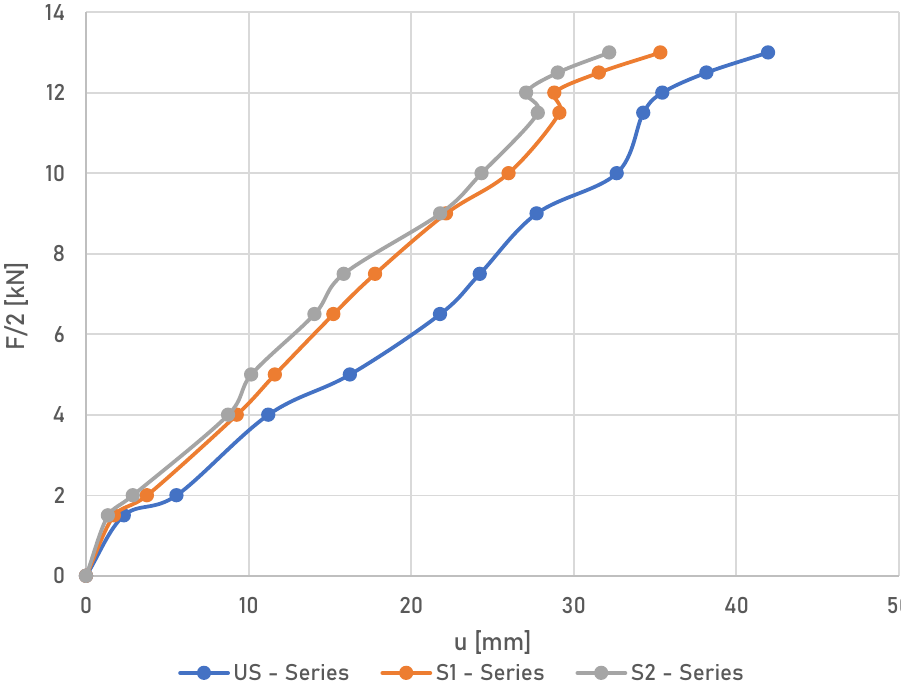
Figure 6. Mid-span load displacement curves averaged for all series.